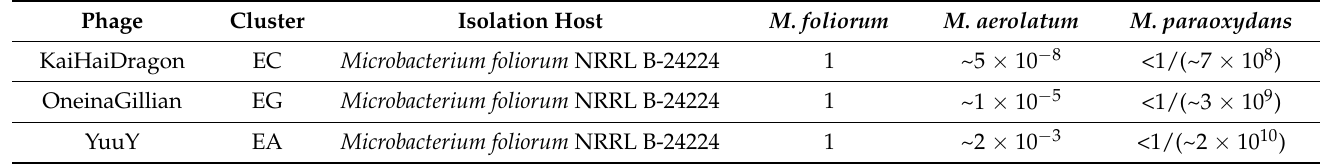
Table 1. Efficiency of plating (EOP) values of each phage on various Microbacterium strains relative to M. foliorum .